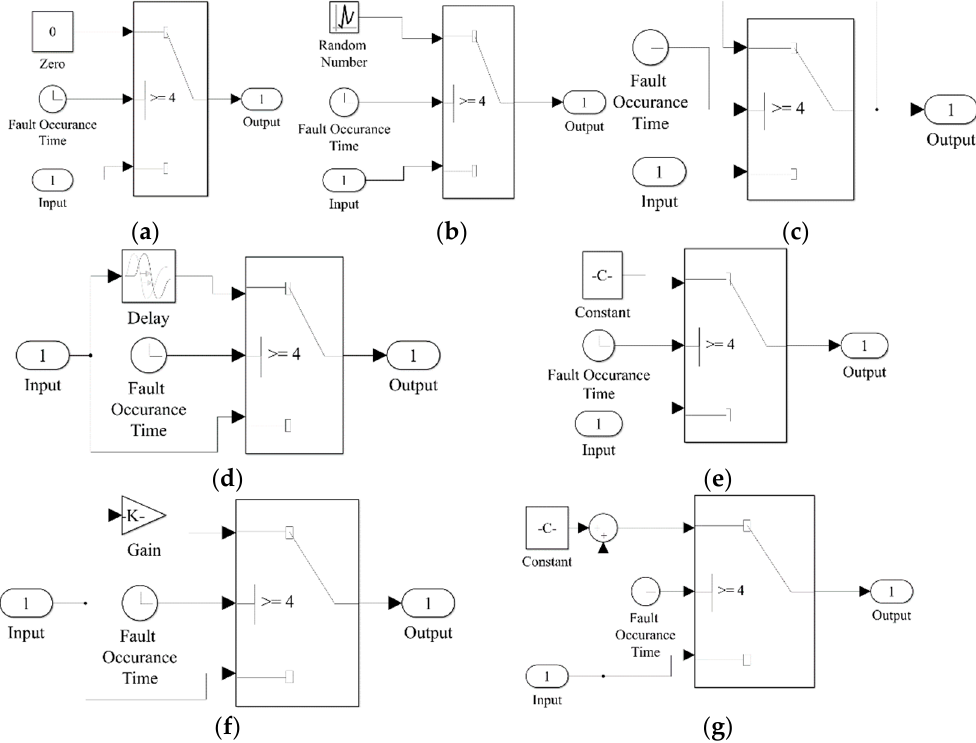
Figure 4. Simulink models of the seven failure modes: ( a ) “omission”, ( b ) “random”, ( c ) “stuck”, ( d ) “delayed”, ( e ) “trailing”, ( f ) “gain change”, and ( g ) “biased”.